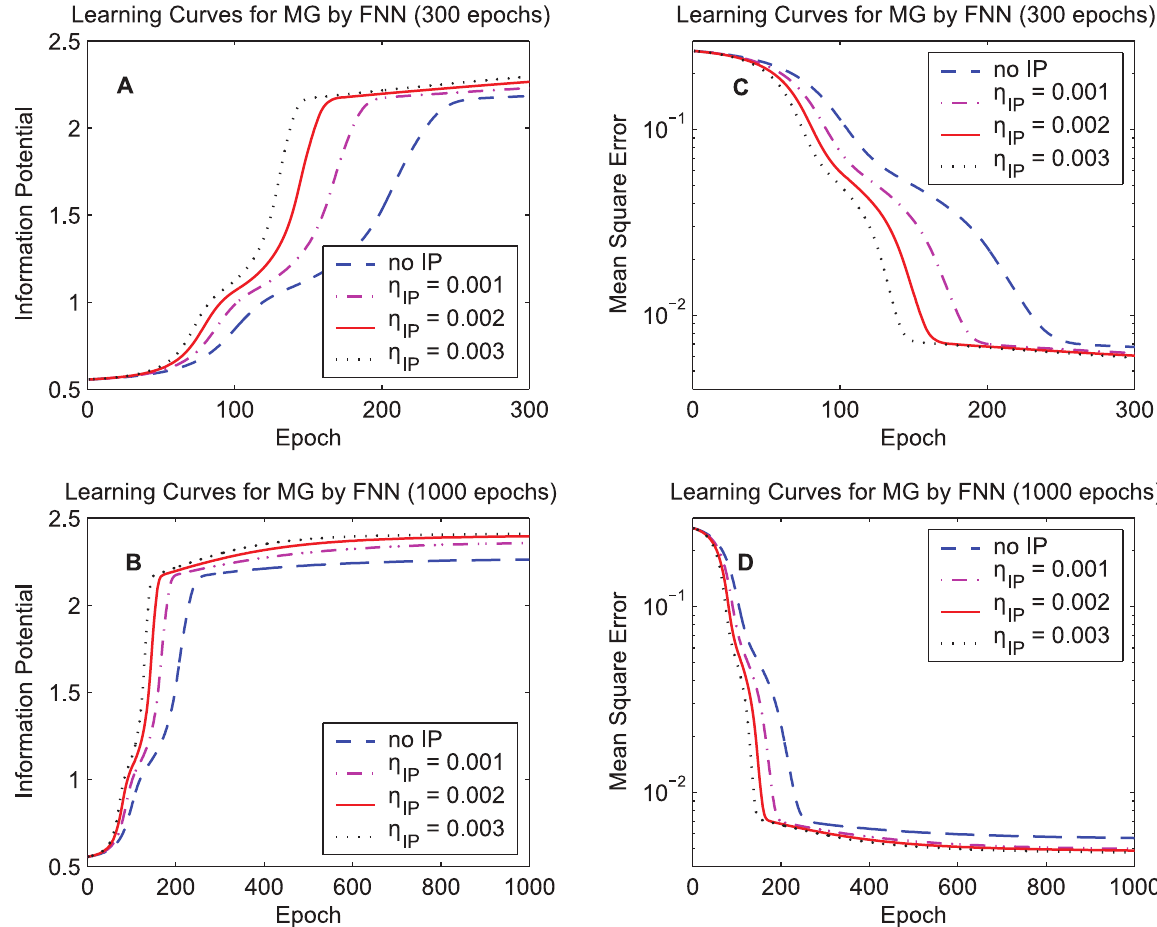
Figure 9. Learning curves of the FNN with different IP learning rates. The training data set ‘‘MG’’ is used. The initial IP learning rates g IP ~ 0 : 001 , g IP ~ 0 : 002 , g IP ~ 0 : 003 , and g IP ~ 0 (no IP) are used for comparison. Learning curves of the quadratic information potential: (A) 300 epochs. (B) 1000 epochs. Learning curves of the mean square error: (C) 300 epochs. (D) 1000 epochs.